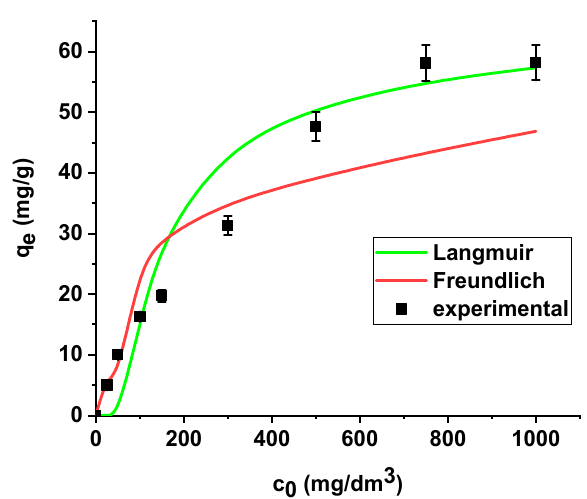
Figure 14. The Langmuir and Freundlich sorption isotherms of As(V) on X np (pH 6, shaking speed 180 rpm, temperature 295 K).